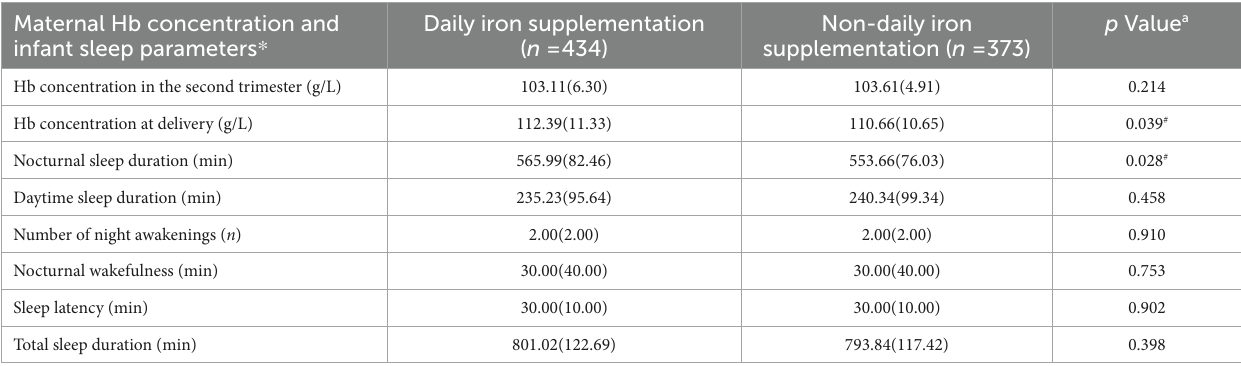
TABLE 3 Comparison of maternal Hb concentration and infant sleep parameters in anemic mothers with daily iron supplementation vs. mothers without daily iron supplementation ( n = 807). Maternal Hb concentration and Daily iron supplementation infant sleep parameters * ( n =